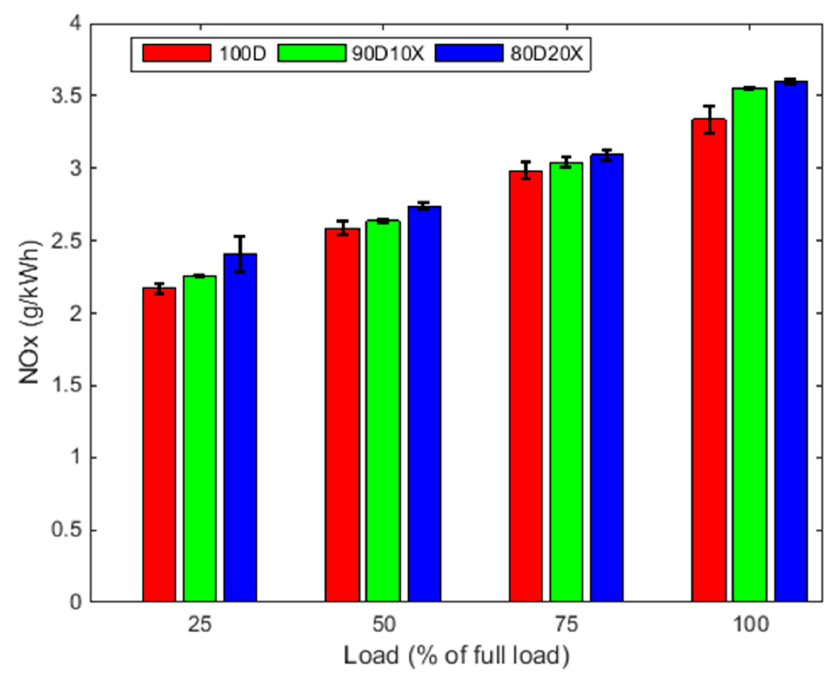
Figure 8. Brake specific NO x emission with engine loads for diesel and DOP blends.